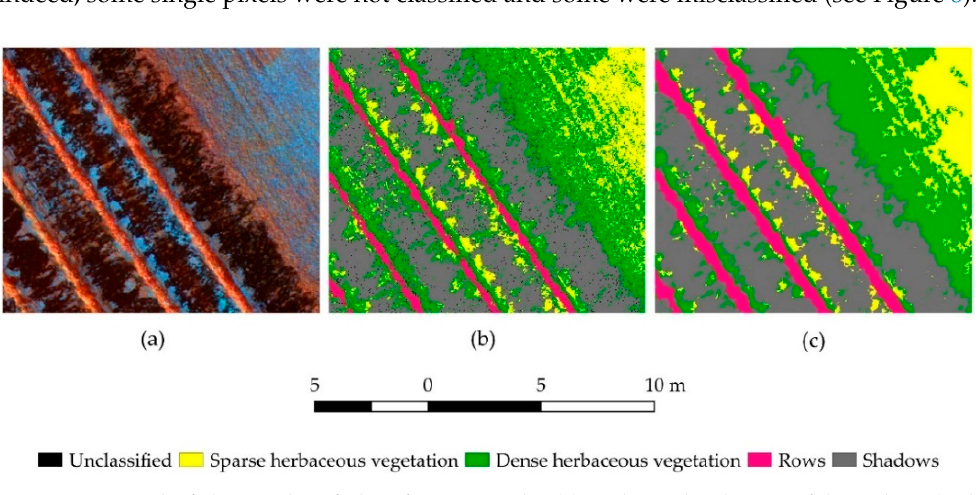
Figure 8. Detail of the results of classification I. The ( a ) is the orthophoto in false colour (redEdge, Green, Red); ( b ) shows the classification I without postprocessing; ( c ) shows postprocessed classification I.